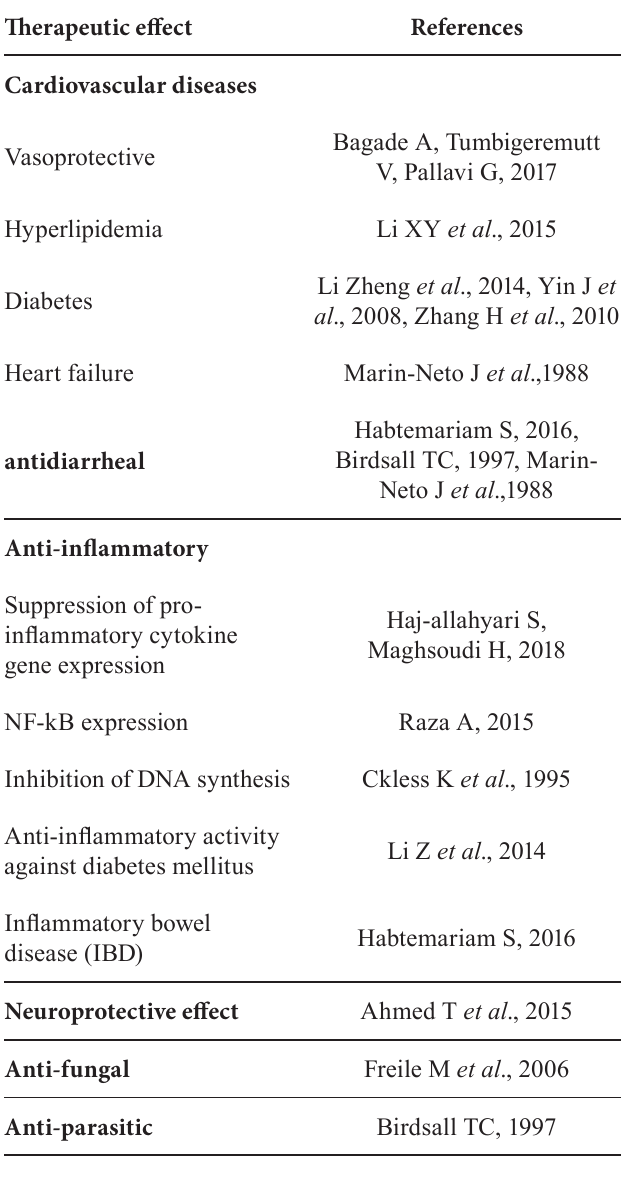
TABLE I - P reliminary studies on various therapeutic effects of